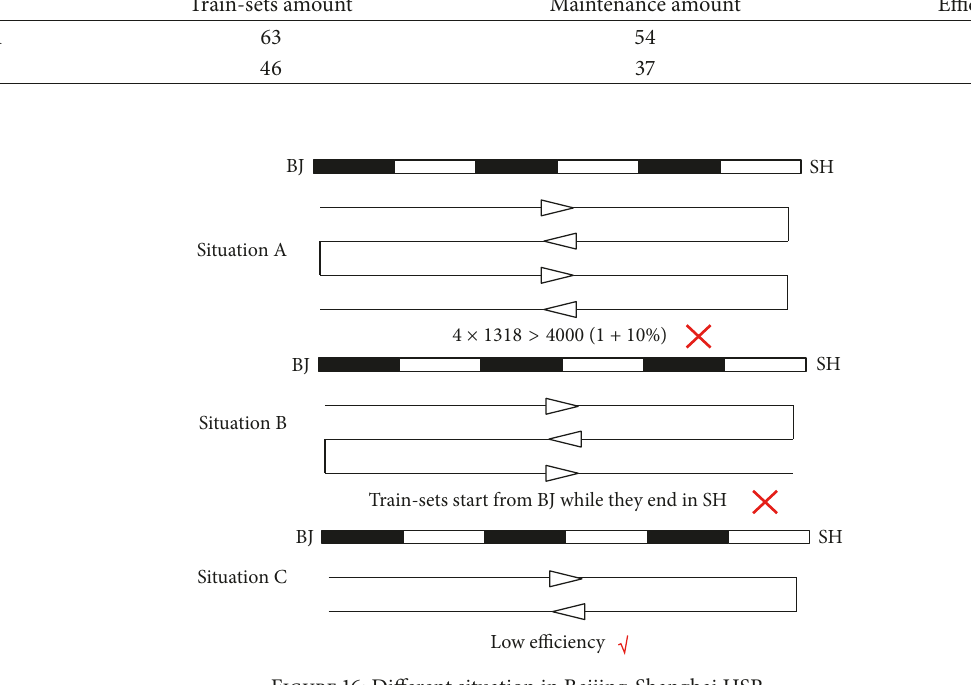
Figure 16: Different situation in Beijing-Shanghai